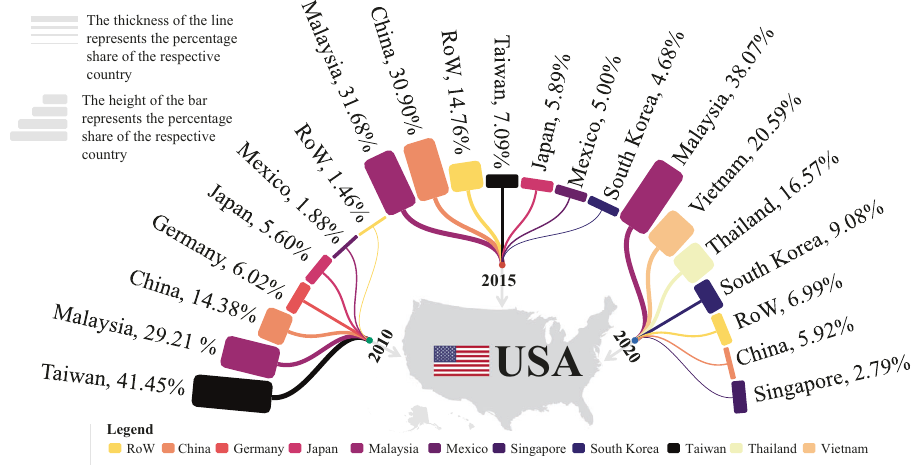
Fig. 5 | Supply chain structure ofsolarphotovoltaic panels shipped to the U.S. in 2010, 2015, and 2020. The suppliers involved in the 2010, 2015, and 2020 outsourced cases are determined based on the market share data. The U.S. mainly imported solar photovoltaic products from Asian trading partners. The